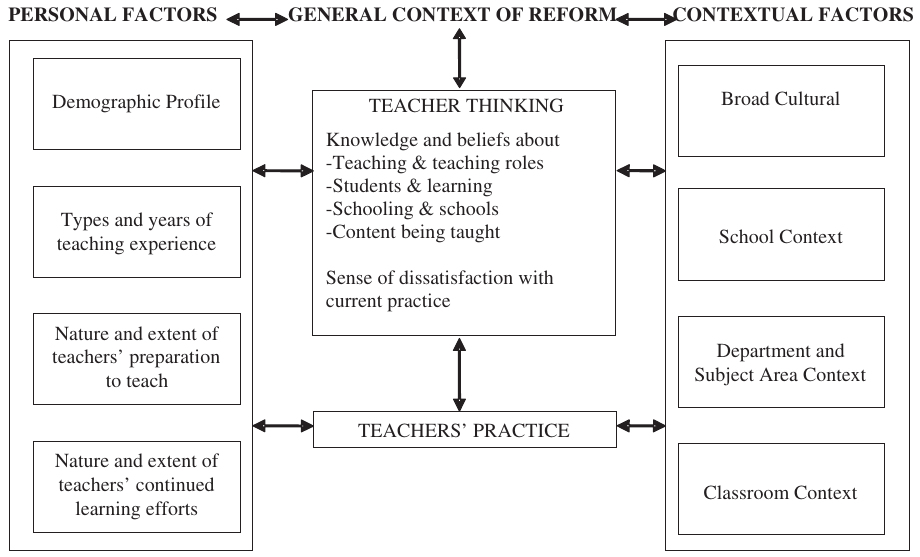
FIG. 1. The Teacher Centered Systemic Reform (TCSR) framework